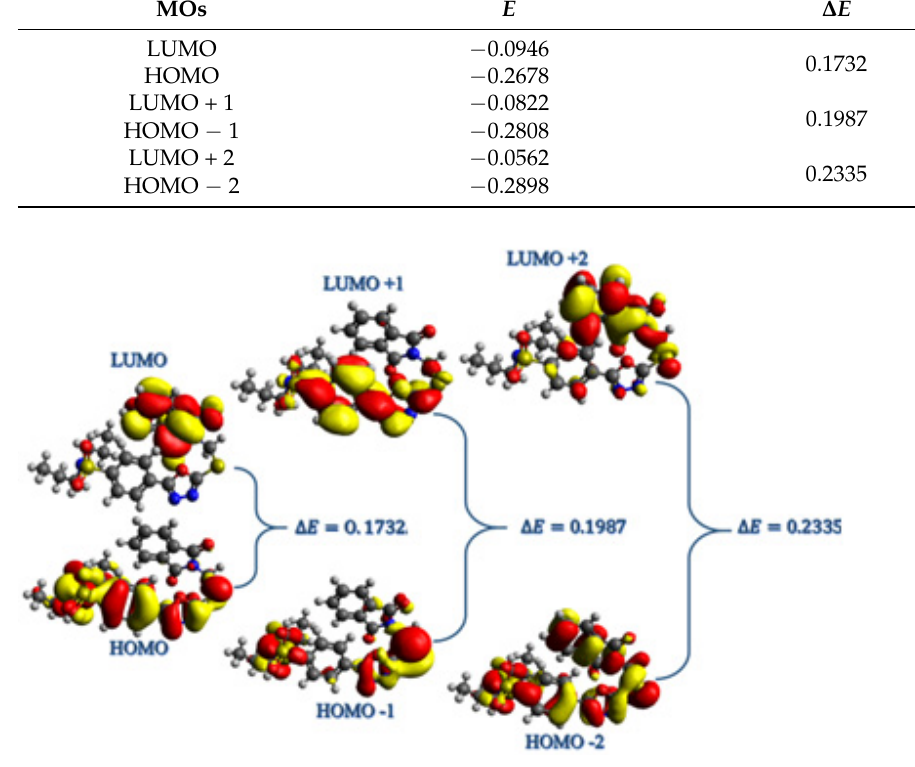
Figure 9. HOMO and LUMO diagrams of the PESMP compound, along with the band gap ( Δ E , in a.u.) energetic values.